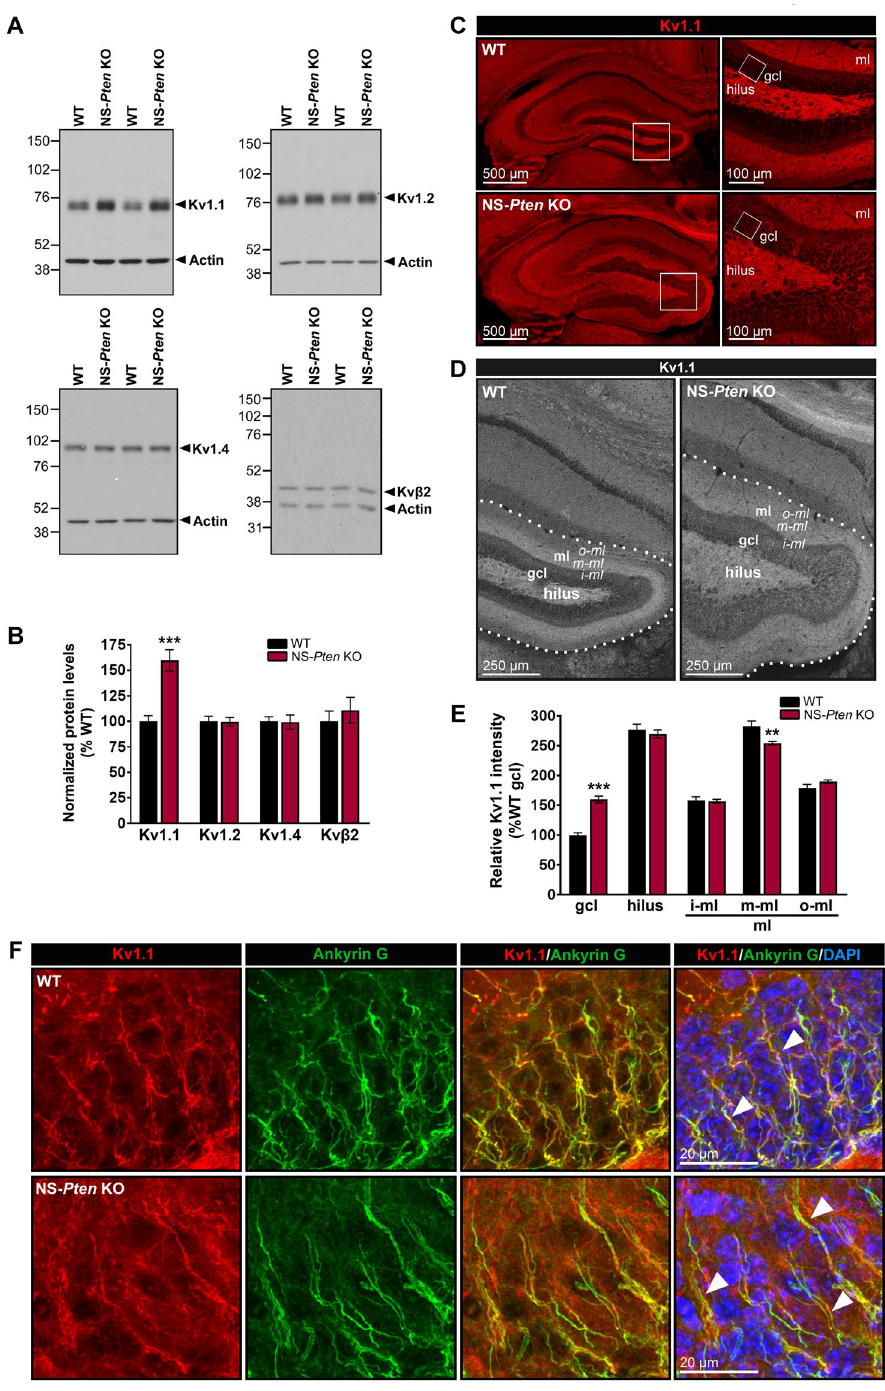
Figure 2. Hippocampal Kv1.1, but not Kv1.2, Kv1.4, or Kv β 2, protein levels are increased in NS- Pten KO mice. ( A ) Representative western blots from whole hippocampal homogenates from 6 week-old WT and NS- Pten KO mice probed with antibodies against Kv1.1, Kv1.2, Kv1.4, Kv β 2, and actin are shown. ( B ) Quantification of the western blots showed that Kv1.1 protein levels were significantly increased in NS- Pten KO compared to WT mice. No changes in Kv1.2, Kv1.4, or Kv β 2 protein levels were observed between NS- Pten KO and WT mice. n = 6–8 mice per group; *** p < 0.001 by Student’s t-test; errors bars are ± SEM. ( C ) Representative single optical sections of Kv1.1 immunostaining in 7 week-old WT and NS- Pten KO hippocampus are shown. White squares in the left panels outline the areas of the DG that are enlarged in the right panels. White squares in the right panels outline the areas of the DG granule cell layer that are enlarged in panel F. Images represent comparable sections from WT and NS- Pten KO mice; note the enlarged NS- Pten KO hippocampus, particularly in the DG where loss of Pten is most substantial. ( D ) Representative, grayscale single optical sections of Kv1.1 immunostaining in WT and NS- Pten KO mice, enlarged to demonstrate the DG hilus, granule cell layer,